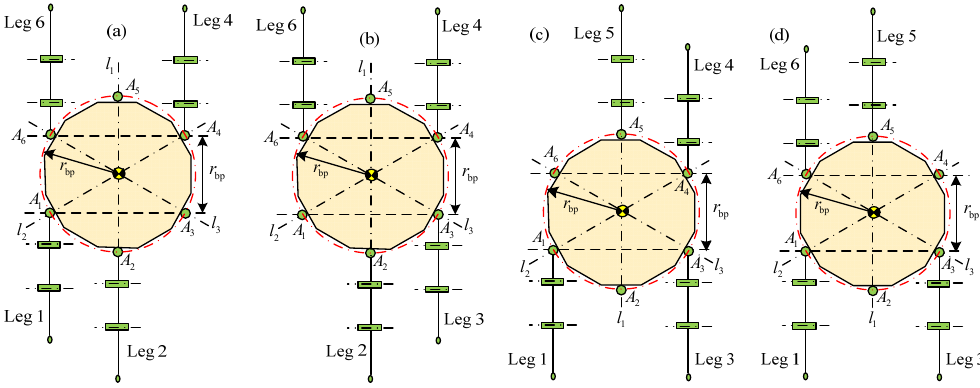
Figure 6. Working condition III of support phase: ( a ) support phase involving legs 1, 2, 4 and 6; ( b ) support phase involving legs 2, 3, 4 and 6; ( c ) support phase involving legs 1, 3, 4 and 5; and ( d ) support phase involving legs 1, 3, 5 and 6.